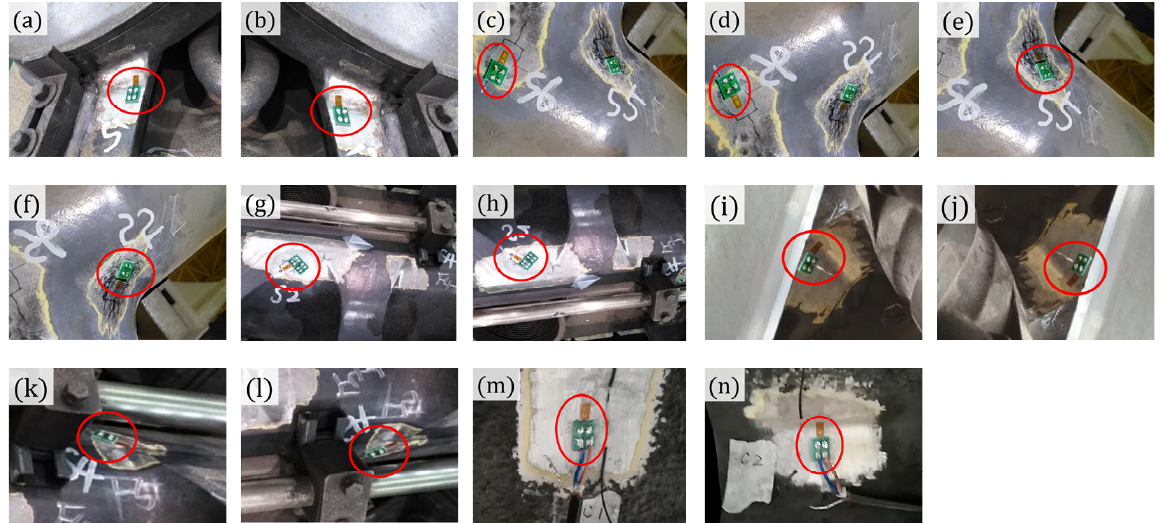
Figure 9. Strain gauge bonding at capture locations on the bogie frame. ( a ) Right air spring base welds; ( b ) Left air spring base welds; ( c ) Left longi ‐ cross beam joint welds; ( d ) Right longi ‐ cross beam joint welds; ( e ) Front traction rod base welds; ( f ) Rear traction rod base welds; ( g ) Front motor base welds; ( h ) Rear motor base welds; ( i ) Left side ‐ cross beam joint welds; ( j ) Right side ‐ cross beam joint welds; ( k ) Front gear box base welds; ( l ) Rear gear box base welds; ( m ) Left lateral damper base welds; ( n ) Right lateral damper base welds.